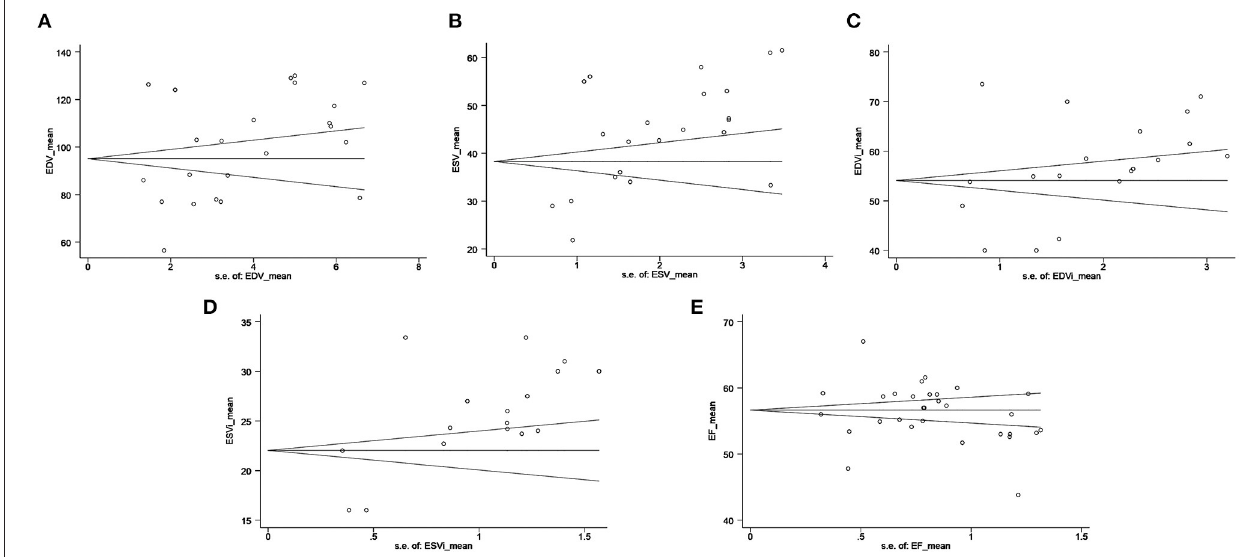
FIGURE 3 | Funnel plot for RV volumes and RVEF: (A) RV EDV ( P = 0.402), (B) RV ESV ( P = 0.011), (C) RV EDVi ( P = 0.357), (D) RV ESVi ( P = 0.007), and (E) RVEF ( P = 0.669). The standard error of the effect estimate is plotted on the horizontal axis. The mean is plotted on the vertical axis. The circle presents each included study. The black lines indicate the pooled mean and 95% CI. 3DE, three-dimensional echocardiography; CI, confidence interval; EDV, end-diastolic volume; EDVi, EDV indexed by body surface area; ESV, end-systolic volume; ESVi, ESV indexed by body surface area; RV, right ventricular; RVEF, RV ejection fraction.